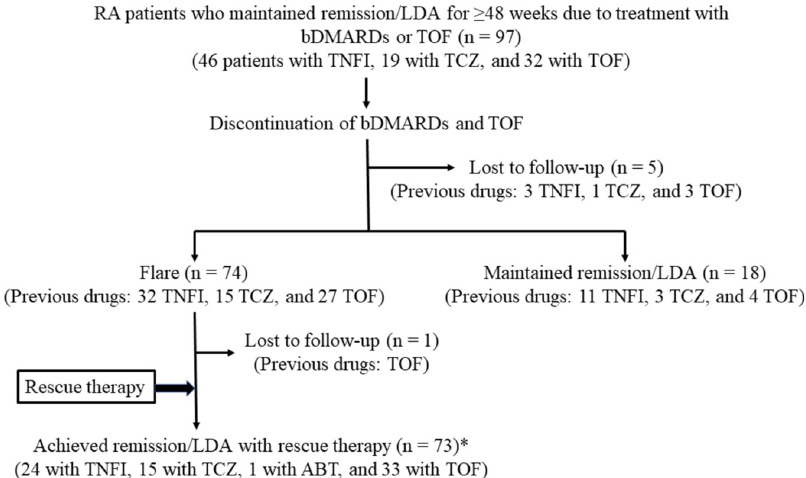
Fig 1. Disposition of patients: Discontinuation of bDMARDs and tofacitinib and rescue therapy. � Patients who experienced a disease flare after discontinuation of TNF inhibitors (n = 32) achieved remission or LDA with the same TNF inhibitors (n = 24), abatacept (n = 1), or tofacitinib (n = 7). The other patients regained a good outcome with previous DMARDs. RA, rheumatoid arthritis; LDA, low disease activity; bDMARDs, biological disease-modifying antirheumatic drugs; TNFI, tumor necrosis factor inhibitor; TCZ, tocilizumab; ABT, abatacept; TOF, tofacitinib.